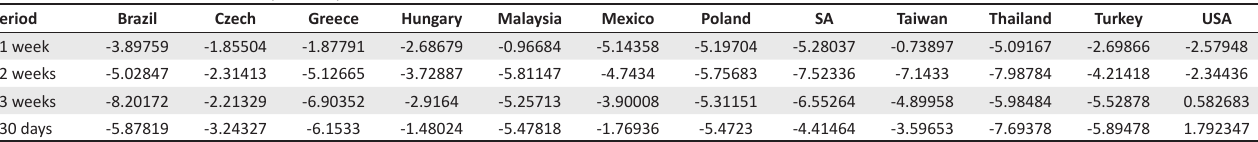
FIGURE 2: Stock market movements since 20 January 2020 TABLE 2: Stock market returns after specified periods. Period